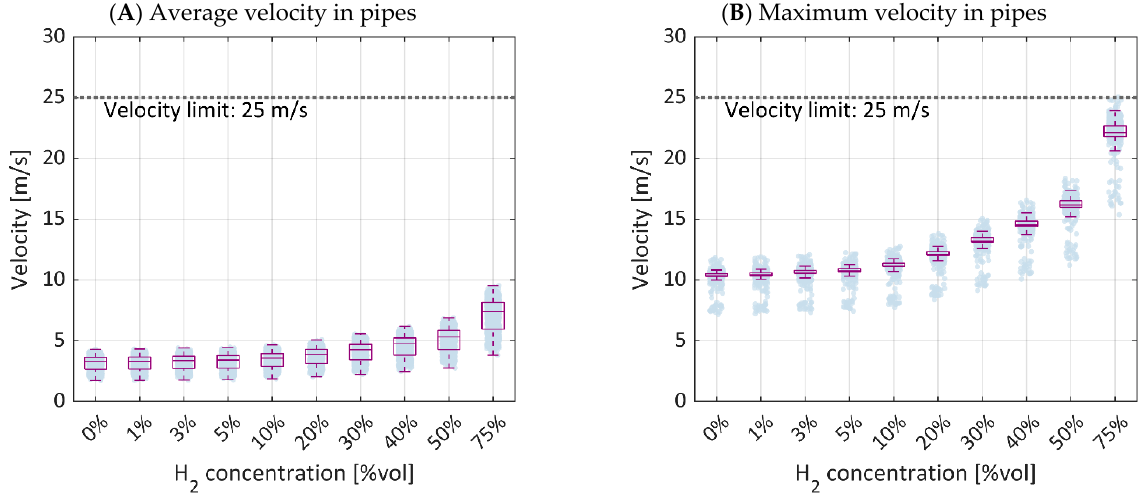
Figure 5. Evolution of average ( A ) and minimum ( B ) nodal pressures recorded in 1000 networks with increasing H 2 concentrations—H 2 –NG blend supplied from the city gate.